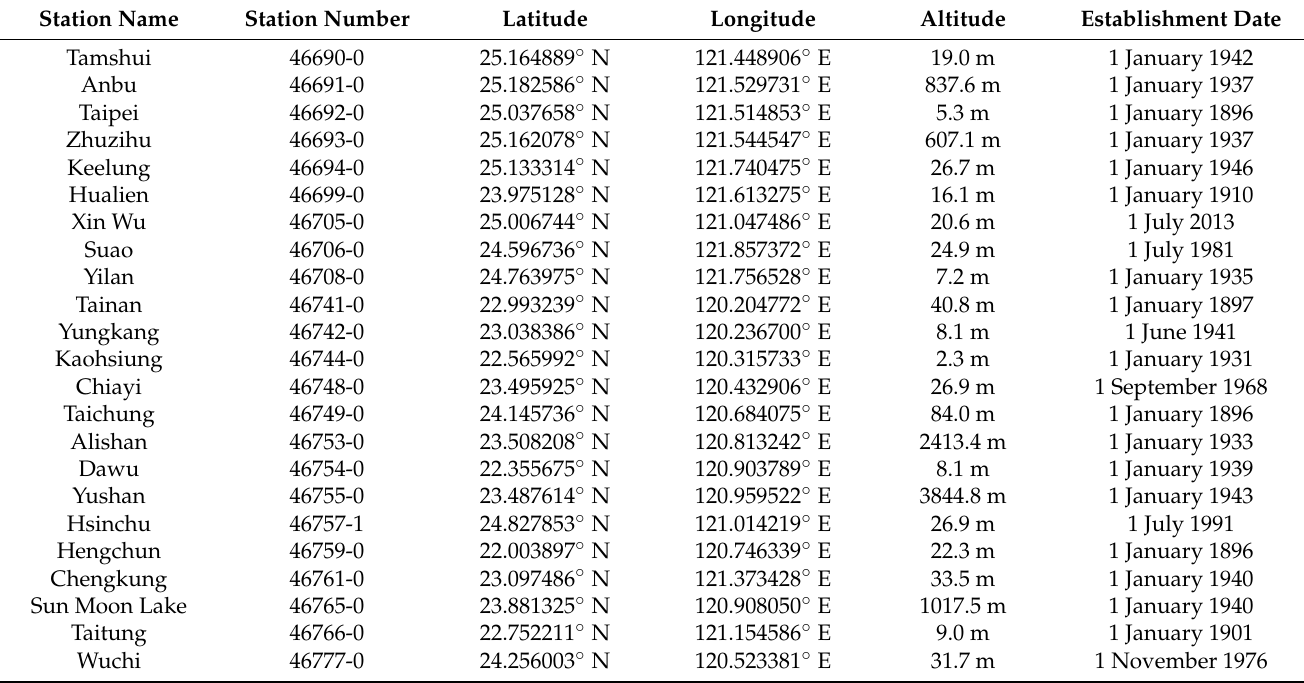
Table 1. Information of the studied CWB conventional weather stations listed in the order of station number.